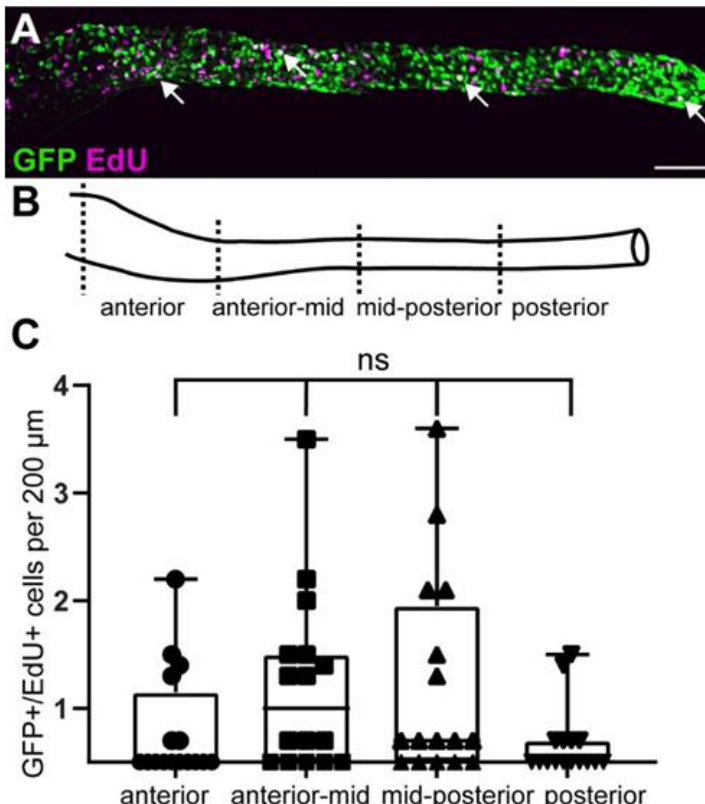
Figure 5. GFP + cells include proliferating enteric progenitor cells at larval stages. ( A ) At 5 dpf, GFP colocalizes with EdU (white arrowheads). ( B ) Gut schematic indicates the four gut sub-regions analyzed. ( C ) Quantification of GFP and EdU colocalization in four gut regions shown in ( B ). Using one-way Anova, we did not find significant differences between the different gut regions. Box plot shows GFP + /EdU + cells (2 experiments, 16 larvae). ( A ): maximum projection of dissected gut. Scale bar = 100 µm. ns not significant.